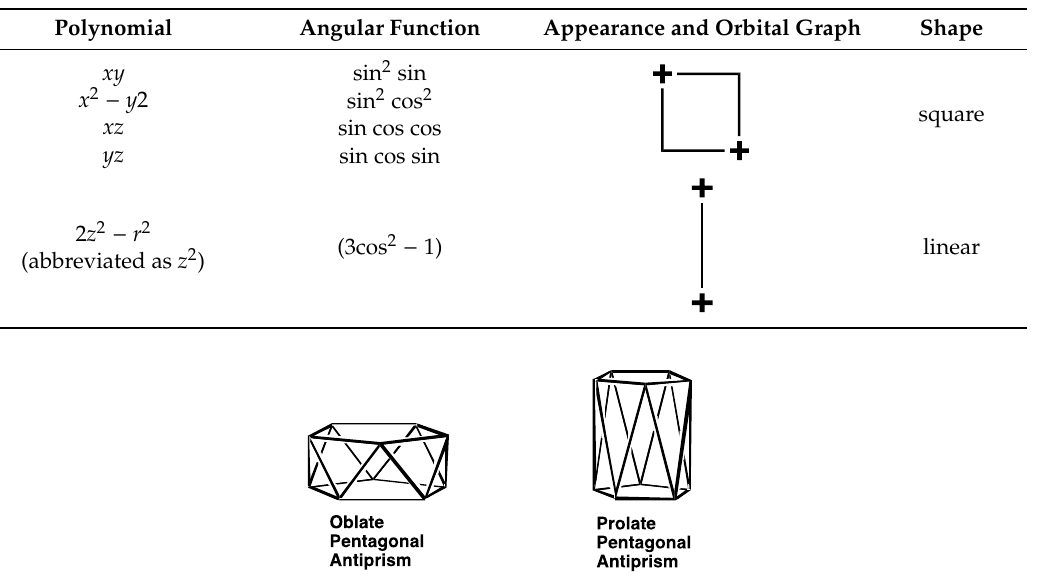
Figure 1. The oblate and prolate pentagonal antiprisms on which the two sets of five equivalent d orbitals are based indicating the amounts of compression and elongation, respectively.